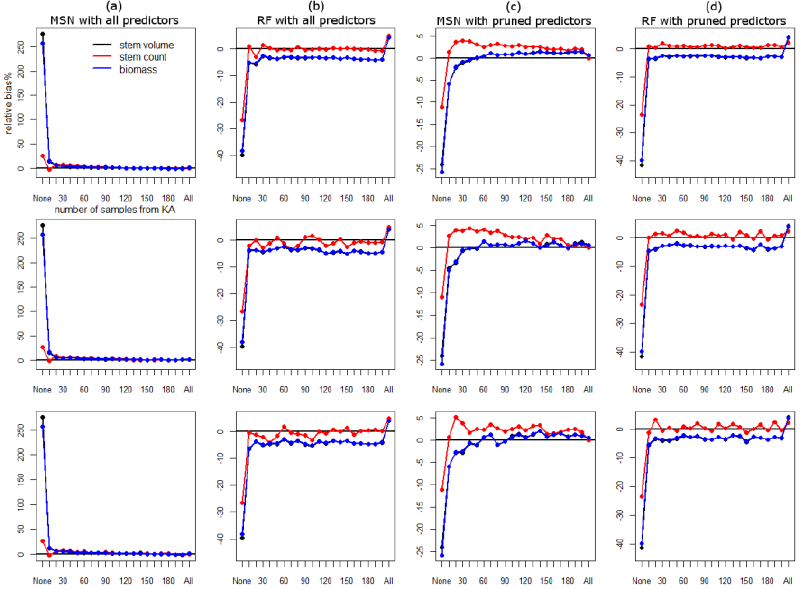
Fig.3. Relative bias% of NN predictions for the entire combinations. Description is similar to Fig.